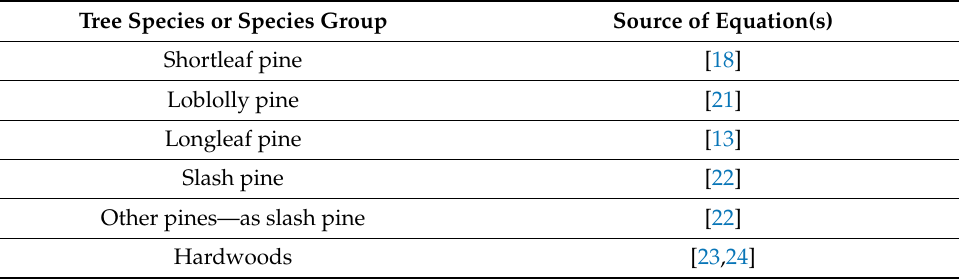
Table 1. Sources of equations for dry biomass